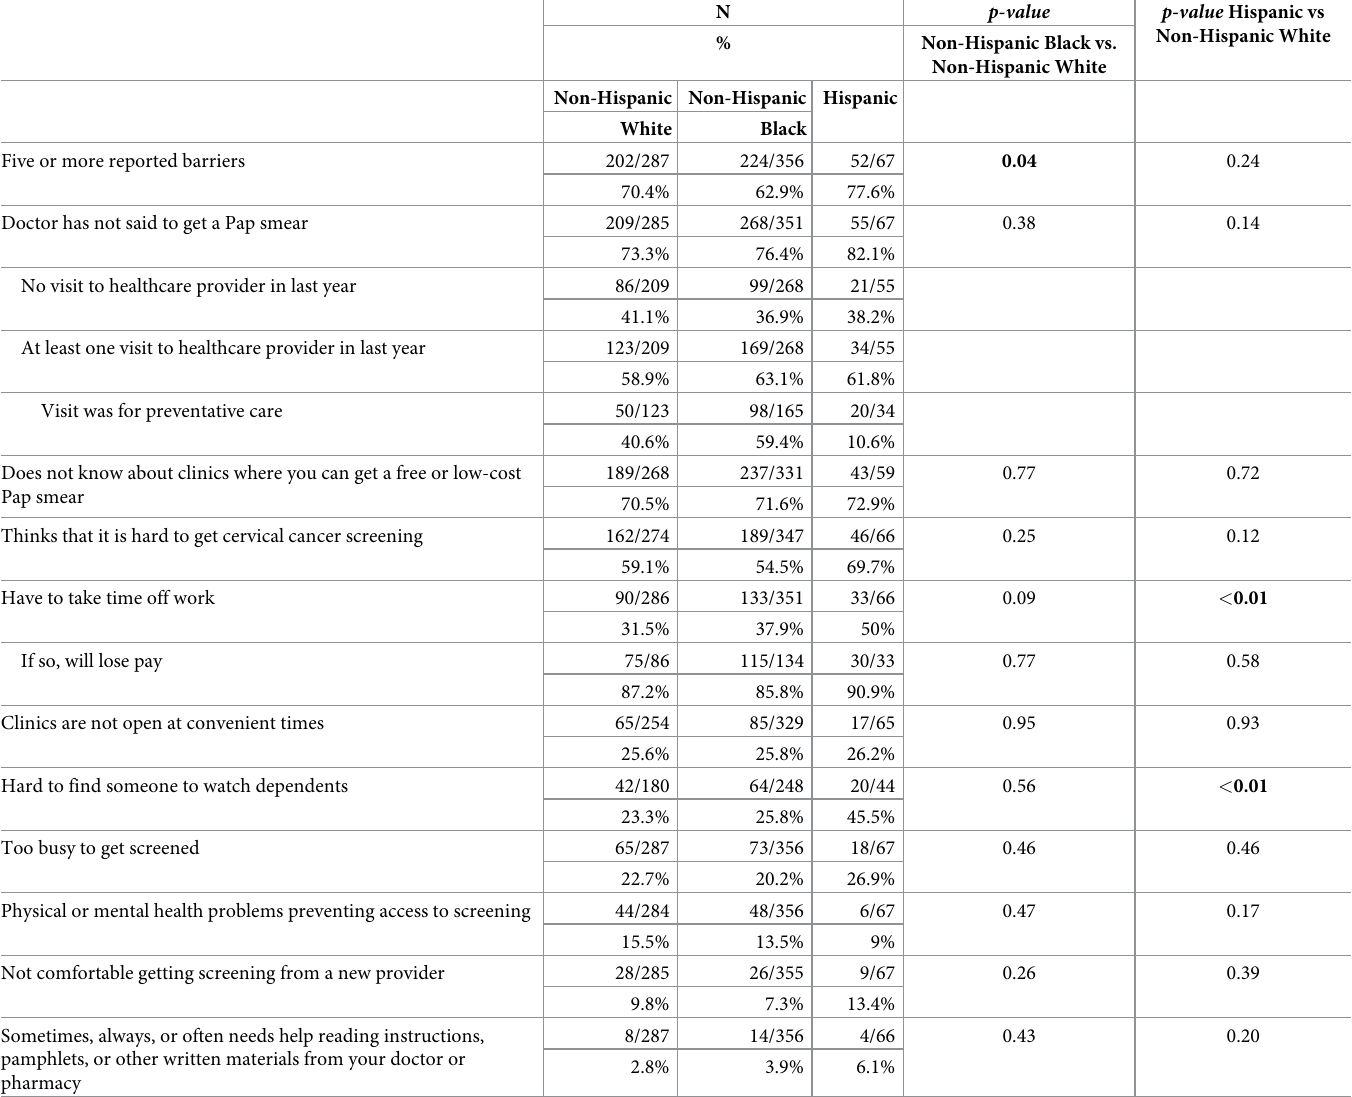
Table 2. Reported barriers to cervical cancer screening, by race and